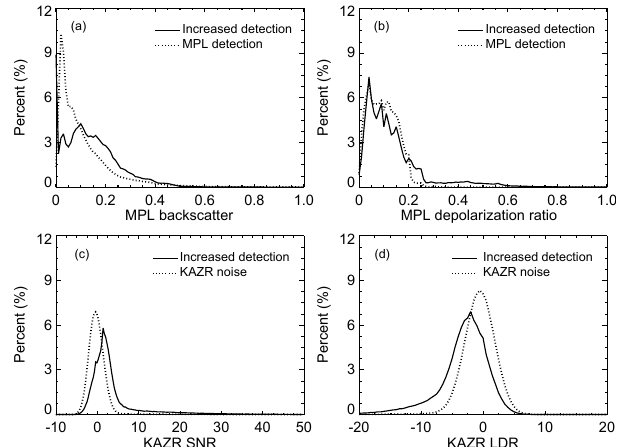
Figure 10. PDF of (a) MPL backscatter, (b) MPL depolarization ratio, (c) KAZR SNR and (d) KAZR LDR for the increased KAZR detections (solid line) and KAZR noise (dashed line)